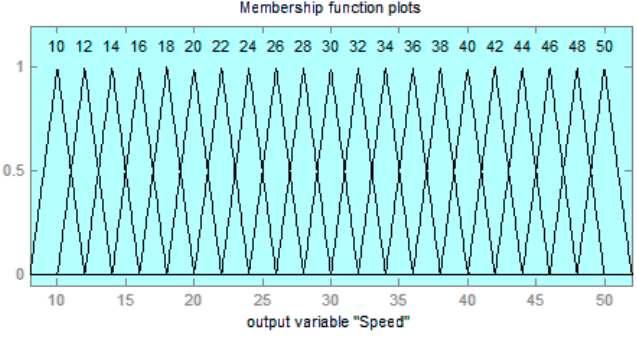
Figure 15. The membership functions plots for speed variable.